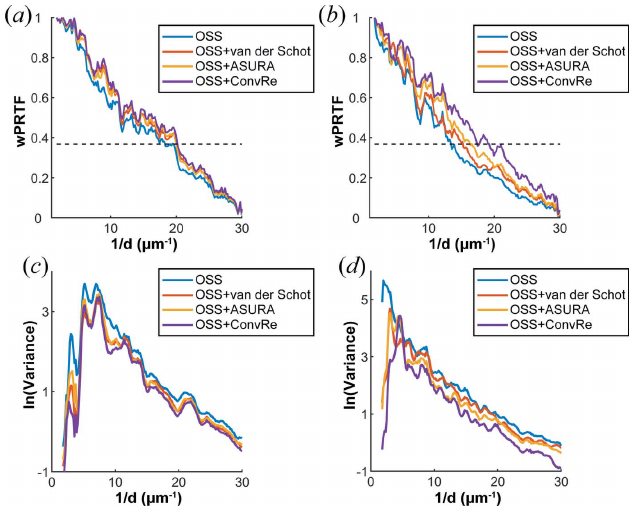
Figure 4 ( a ) and ( b ) The wPRTF curves of different algorithms at doses of ( a ) 30.1 MGy and ( b ) 113 MGy as a function of the resolution 1/ d . The value of the dashed line is 1/e, which serves as the criterion for the highest achieved resolution. ( c ) and ( d ) The natural logarithmic variance of different algorithms at ( c ) 30.1 MGy and ( d ) 113